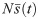
Preliminary results from Boltzmann learning.(A) Evolution of the total-population activity Ns¯(t) of N = 159 neurons produced by the Glauber dynamics (implemented in NEST [96]; see section “Simulation of Glauber dynamics with NEST”) with 106 steps, during the sampling phase of the last Boltzmann-learning iteration. (B) Red, solid: Preliminary approximation of the probability distribution of the population-averaged activity, obtained via Boltzmann learning. Blue, dashed: empirical distribution of the population-averaged activity from the dataset shown in A. (C) Preliminary values of the time averages mi and gij obtained from Boltzmann learning described in (A), versus the experimental ones shown in Fig 1. (D) Preliminary approximations of the population distributions of the Lagrange multipliers h^i and J^ij (associated with the averages mi and gij) obtained via Boltzmann learning. Histogram bins in D are computed with Knuth’s rule [92].